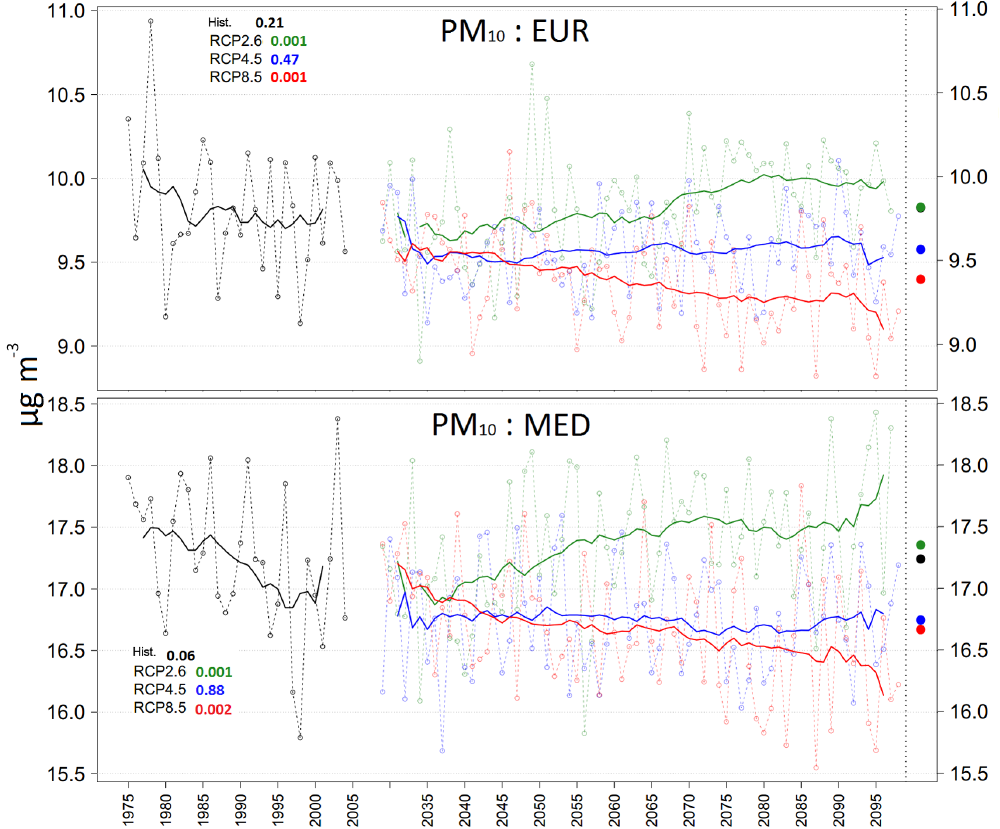
Figure 4. PM 10 time series for the EUR and MED subdomains for all climate change scenarios and historic simulations. The average for each scenario is shown by the corresponding point on right side of the plot. The solid lines show the rolling average of 30 years for future scenarios and 20 years for historic scenarios. Numbers in the legend indicate the p value of the linear regression for each